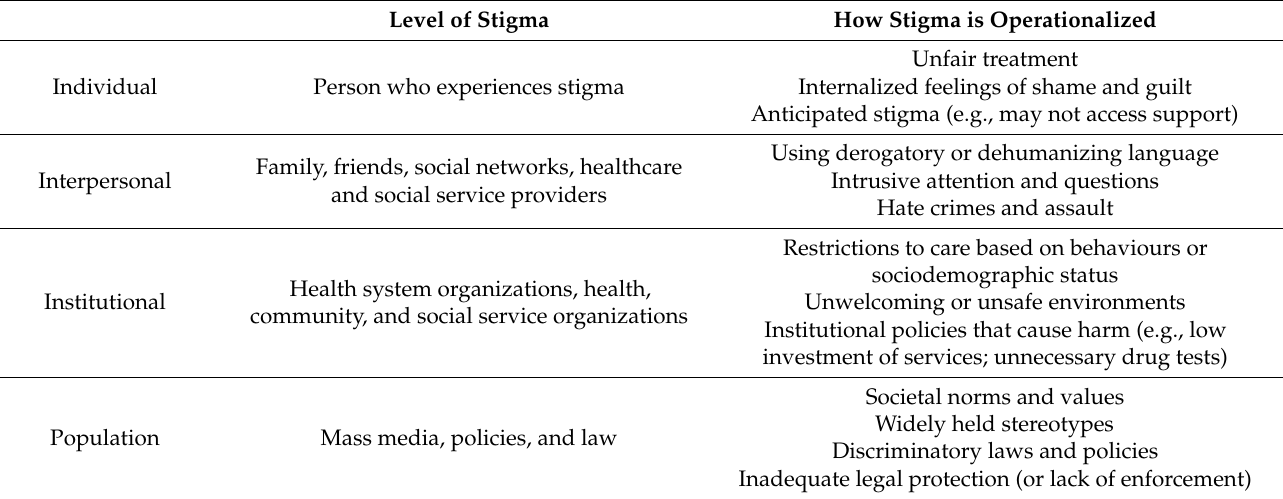
Table 1. Stigma Action